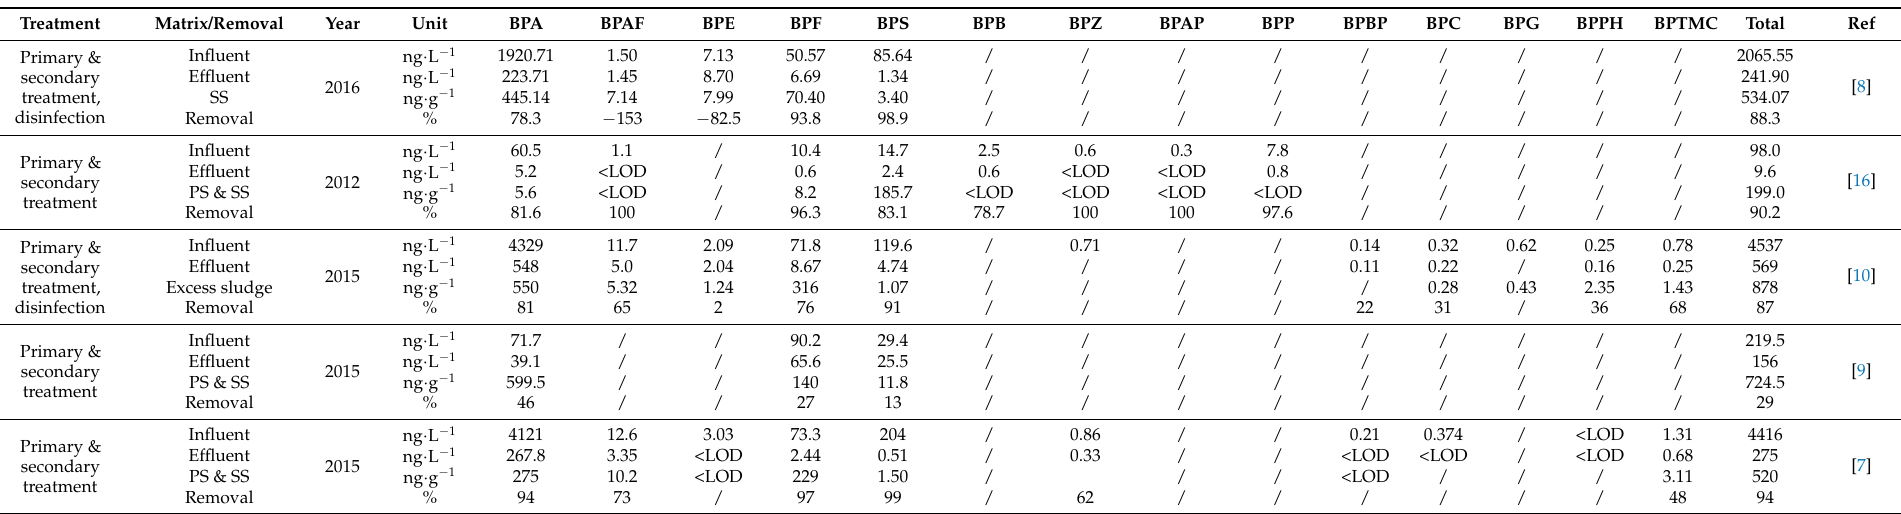
Table 1. Mean concentrations of BPs in influent, effluent and